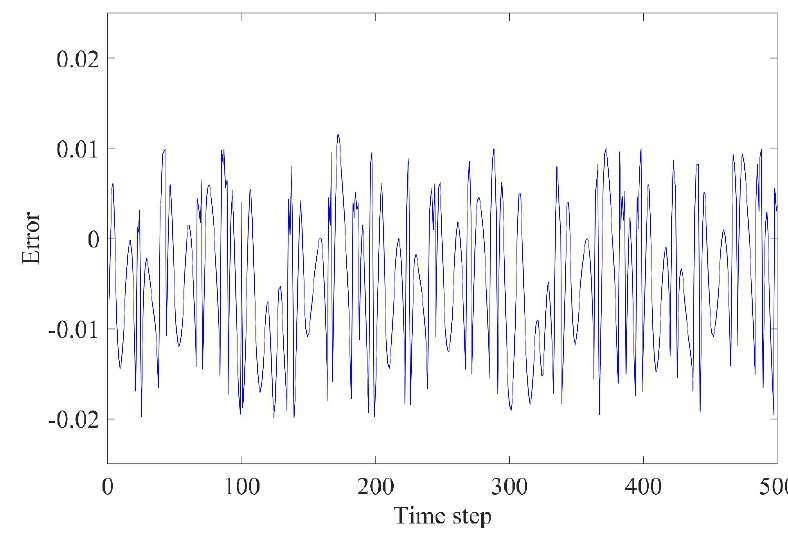
Figure 11. The prediction errors of chaotic time series obtained using the STFCMAC model.